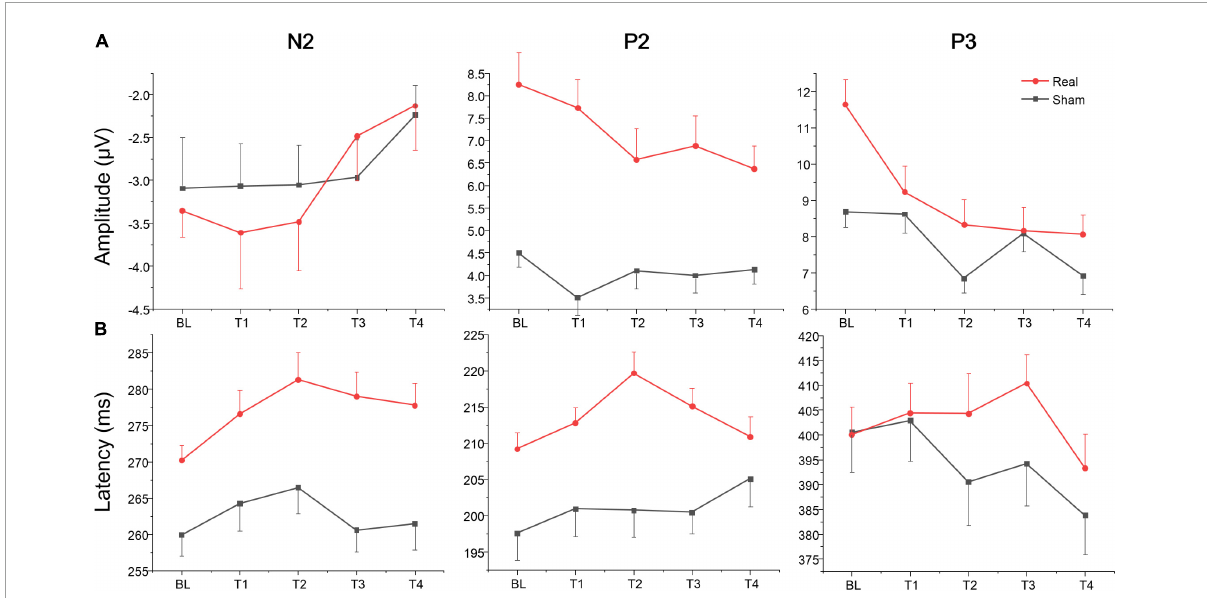
FIGURE5 Amplitude and latency of ERPs component for Oddball task at each time point. (A) Mean amplitudes of N2, P2, and P3. (B) Mean latencies of N2, P2, and P3.